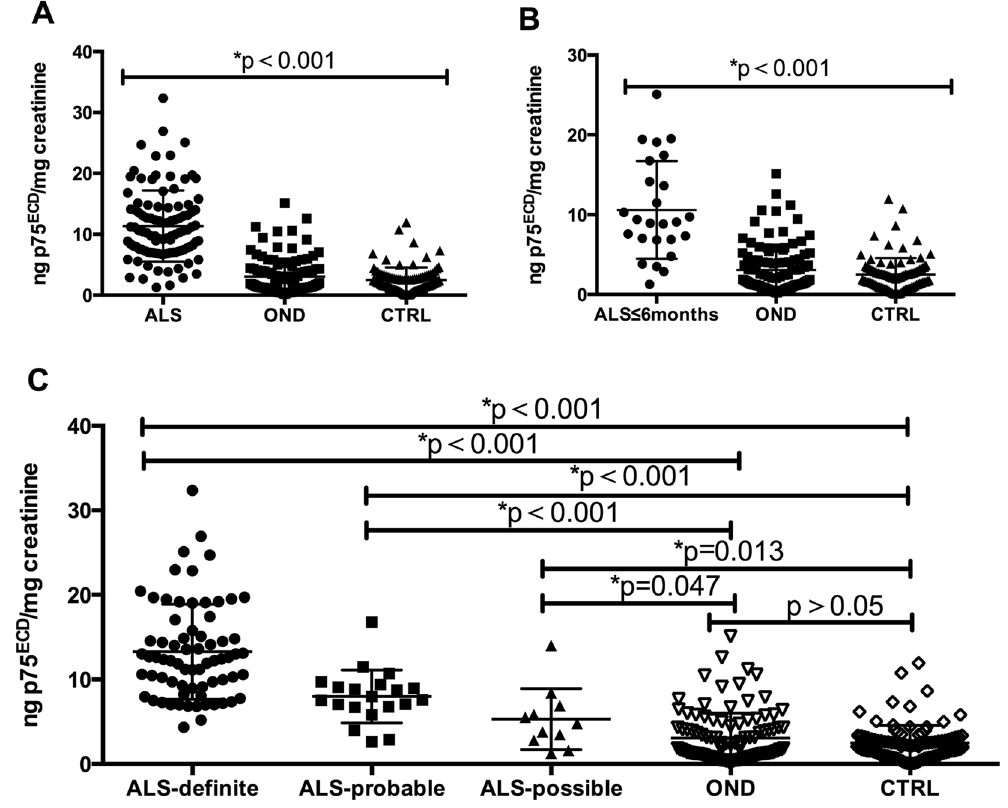
Figure 1. Comparison of p75 ECD in urine between different groups and ALS Diagnostic Grades: ( A ) Urine p75 ECD in ALS was higher than OND and CTRL by one way ANOVA (p < 0.001). ( B ) Urine p75 ECD in ALS (onset less than 6 months) was higher than OND and CTRL by one way ANOVA (p < 0.001). ( C ) Urine p75 ECD was different among three ALS diagnosis grades (p < 0.001), and the rank test among them suggests that urine p75 ECD increased with ALS diagnostic degree (p <